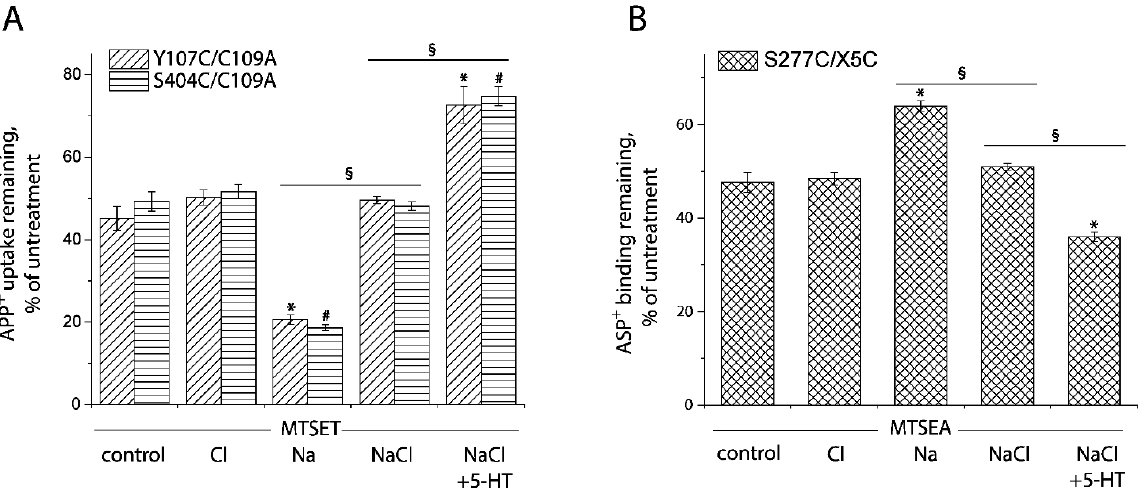
Figure 8. Ion-induced accessibility changes in both the extracellular and cytoplasmic pathways. ( A ) Ion-induced accessibility changes in the extracellular pathway. The cells stably